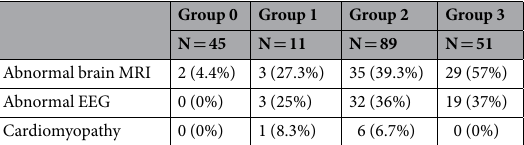
Table 5. Brain imaging (MRI), electroencephalogram (EEG) and heart findings in the 196 neonates for whom metabolic testings were performed. Group 0: neonates with a final diagnosis of transient disorder; group 1: neonates diagnosed with IMD confirmed by molecular testing; group 2: neonates suffering from a non-metabolic disease; group 3: neonates with chronic clinical abnormalities but for whom no diagnosis could be made.